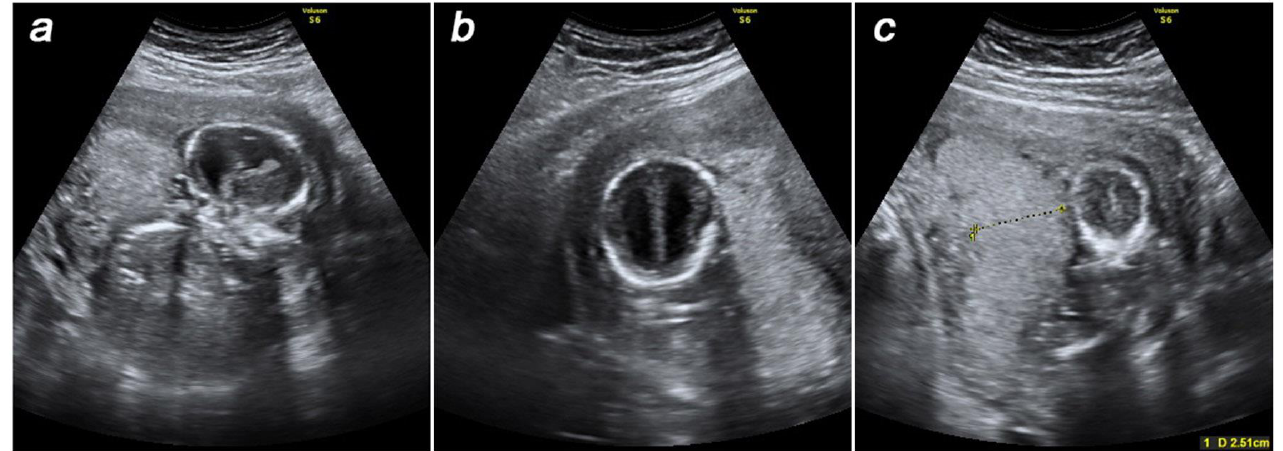
Figure 1. Prenatal ultrasound findings at 16–17 weeks of gestation: dolichocephaly ( a ), ventriculo- megaly ( b ), thick placenta ( c ).